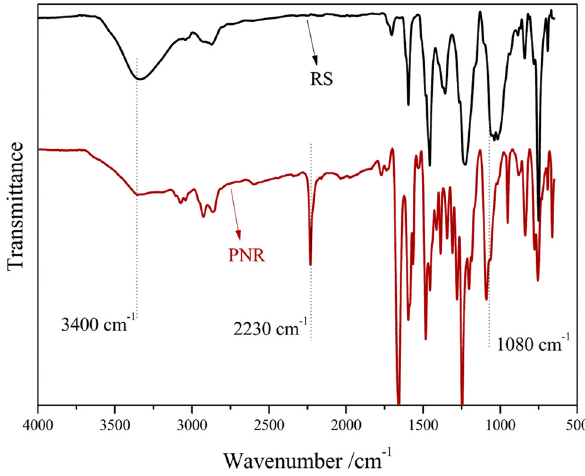
Figure 2: FT - IR spectra of PNR and